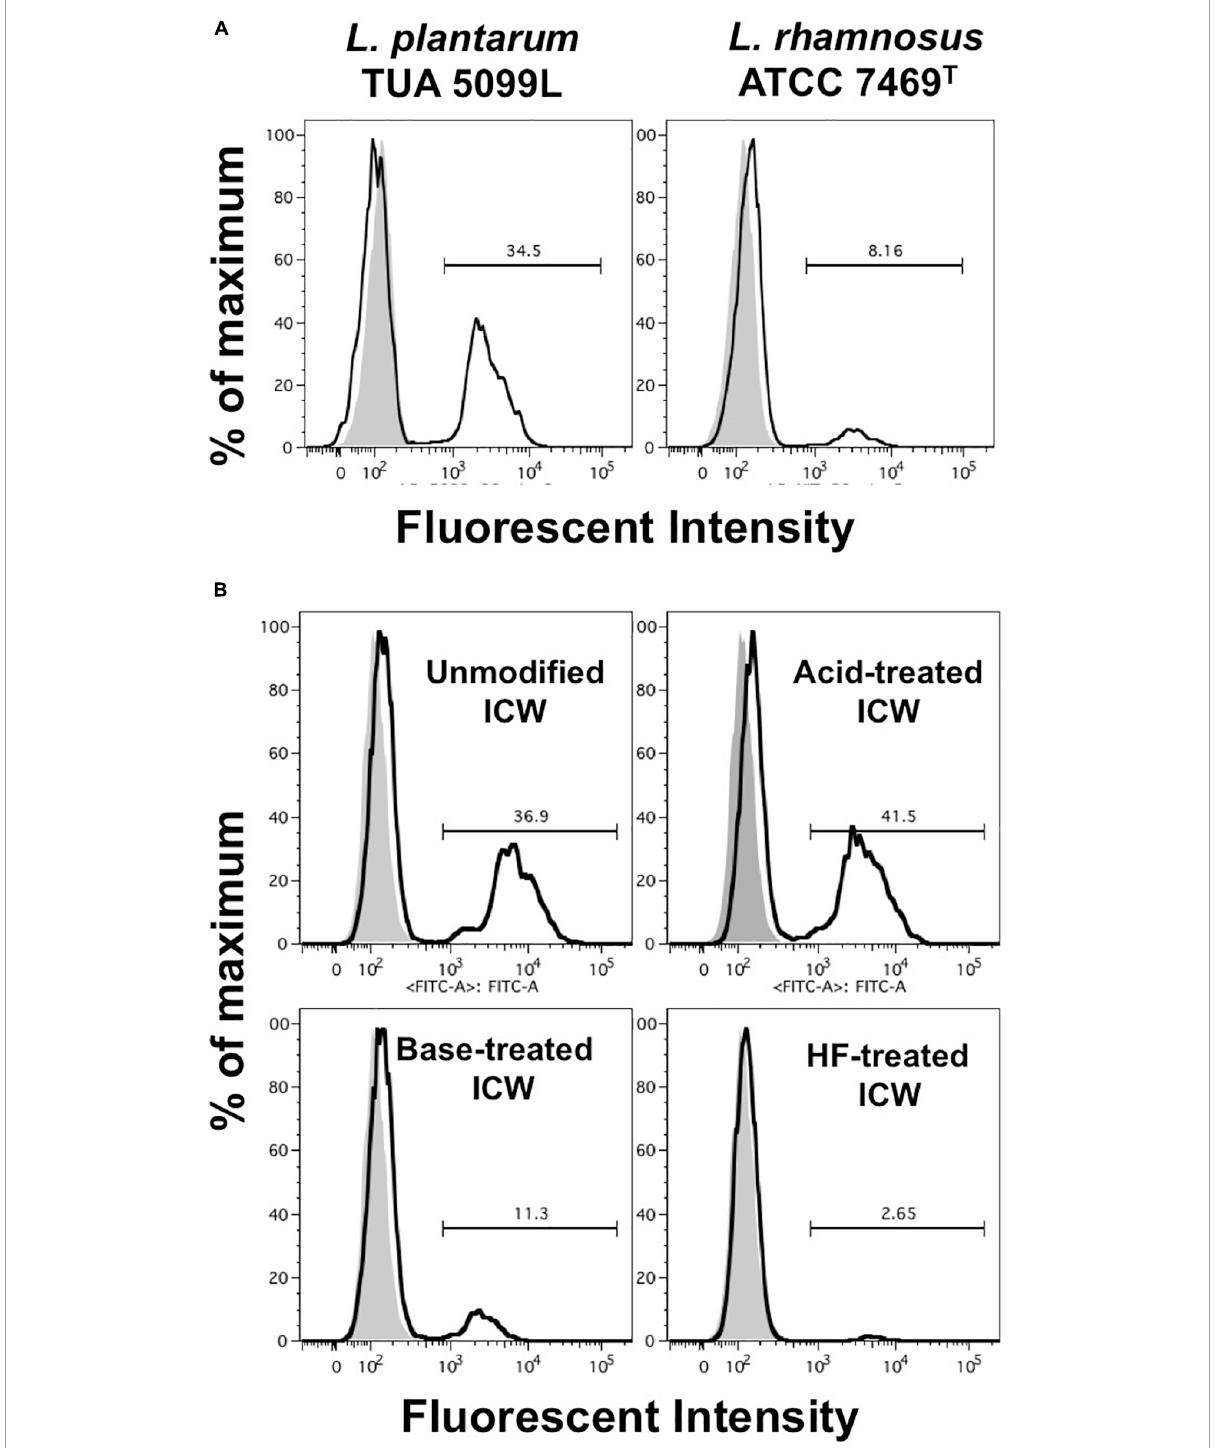
FIGURE7 Uptake of ICWs into macrophages. (A) J774.1 cells were incubated with fluorescein-labeled WTA-displaying ICWs of L. plantarum TUA 5099L and WTA-lacking ICWs of L. rhamnosus ATCC 7496 T for 30 min at 37 ◦ C with gentle rotation. Cells were washed with PBS and fluorescent signals in the cells were then analyzed by flow cytometry. Representative results of two independent experiments are shown. Gray and open histograms indicate untreated and fluorescein-labeled ICWs treated cells, respectively. (B) J774.1 cells were incubated with chemically modified ICWs prepared from fluorescein-labeled ICWs of L. plantarum TUA 5099 for 30 min and fluorescent signals in the cells were analyzed. Representative results of two independent experiments are shown. Gray and open histograms indicate untreated and fluorescein-labeled ICWs treated cells,